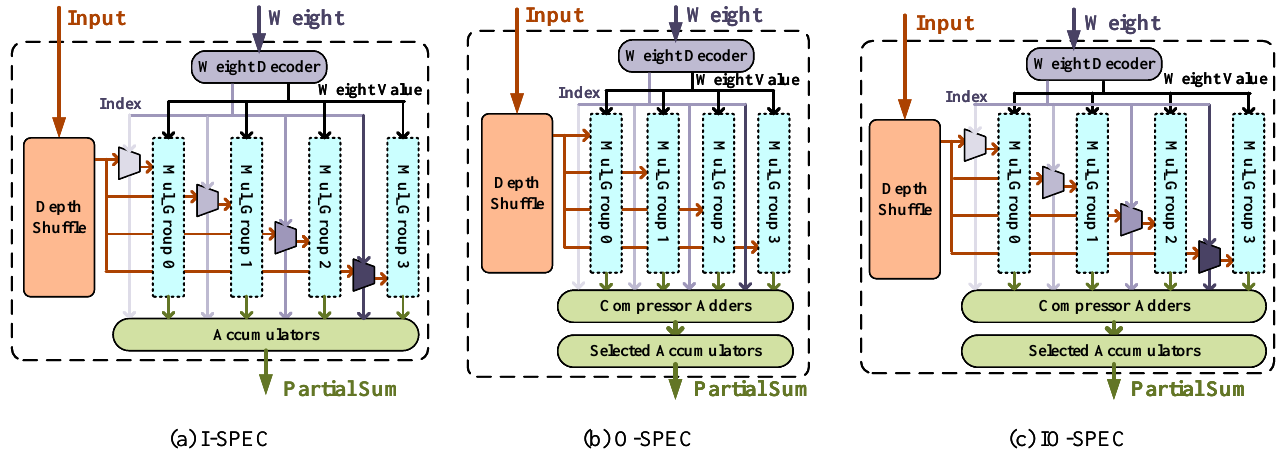
Figure 3. SPECs for different N : M sparse patterns. ( a ) presents the input-channel-wise sparse SPEC, i.e., I-SPEC. ( b ) denotes the output-channel-wise sparse SPEC, i.e., O-SPEC. ( c ) shows the SPEC architecture supporting both input-channel-wise and output-channel-wise sparsity. Three types of SPECs processing different channel-wise sparse are illustrated in Figure 3. The I-SPEC, shown in Figure 3a, is utilized for the input-channel-wise N : M sparse pattern acceleration. Independent data selectors are inserted before input ports of multiple groups to support input channel sparse. The output ports of groups are connected